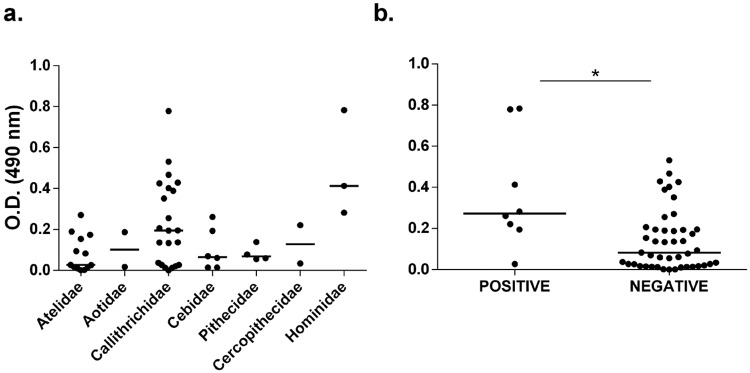
ELISA anti- Lutzomyia longipalpis saliva.(A) O.D. from each non-human primate evaluated distributed according their families. (B) O.D. from non-human primates grouped in positive and negative to Leishmania spp. by xenodiagnosis. Positive animals had statistically significant higher O.D. values when compared to negative animals (*p = 0.0049 –Mann-Whitney test). Line represents the median and dots indicate individual values.